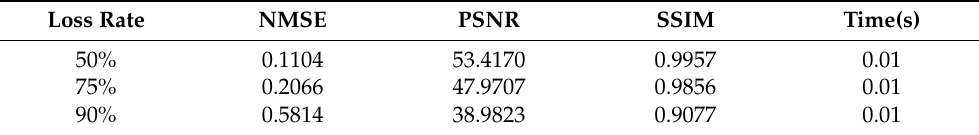
Table 9. Performance evaluation for the simulated data with different loss rates under the 15 dB